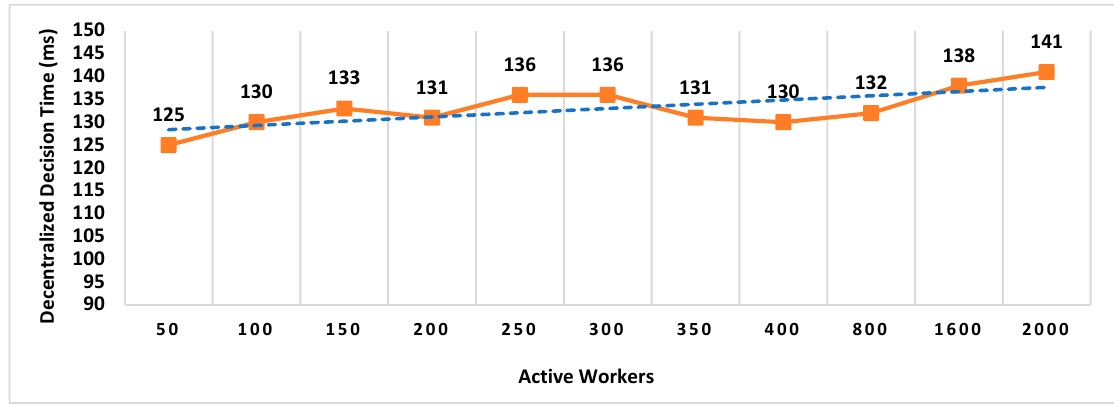
Figure 3. Impact of the number of active workers on the decentralized decision time.